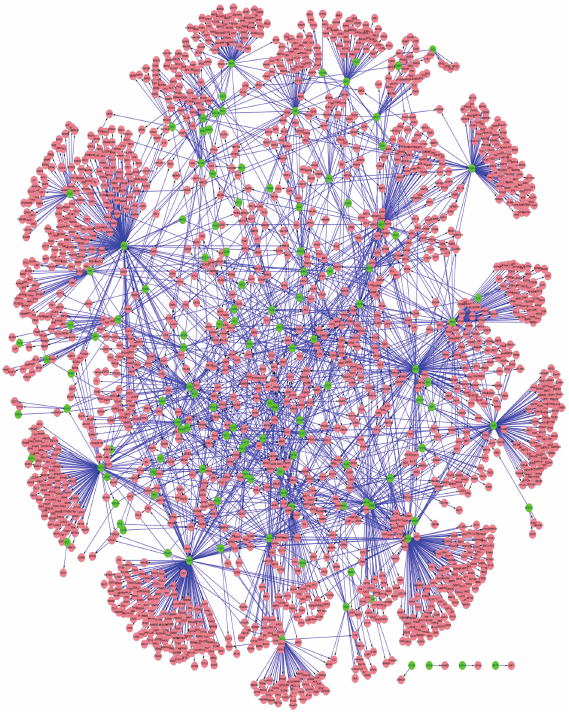
Figure 1: Differentially regulatory network (showing the top 25% relationships). Green nodes represent TFs, pink nodes represent tar- get genes, and lines represent the regulation relationships between